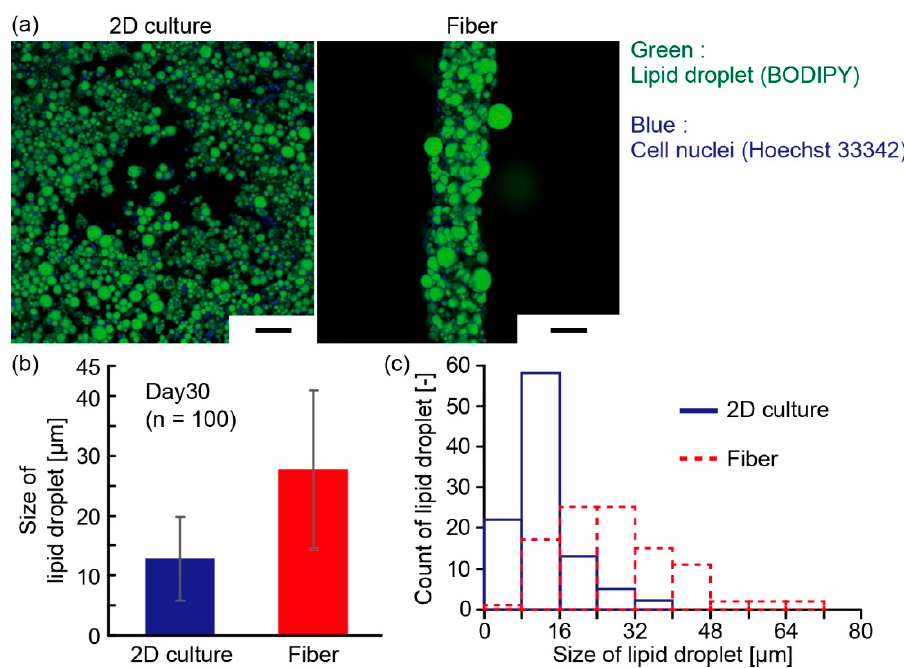
Figure 7. Comparison of 2D-cultured adipocytes in a dish and adipocytes in a microfiber: ( a ) Fluorescence images of lipid droplets in 2D culture and microfiber culture; ( b ) Average size (n = 100, mean ± s. d.) and ( c ) size distribution of lipid droplets on day 30 in both culture conditions. Scale bars are 100 µm.